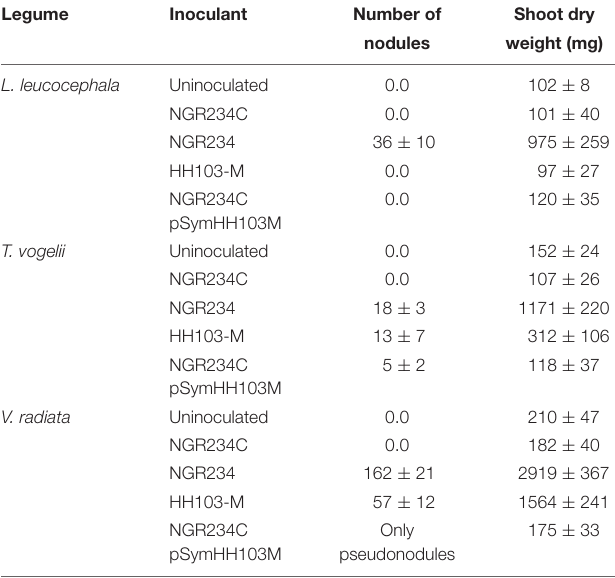
TABLE 8 | Leucaena leucocephala , T. vogelii , and V. radiata responses to inoculation with a NGR234 pSym-cured derivative (ANU265) carrying the symbiotic plasmid of HH103 Rif R tagged with Tn 5 -Mob. Legume Inoculant Number of Shoot dry nodules weight